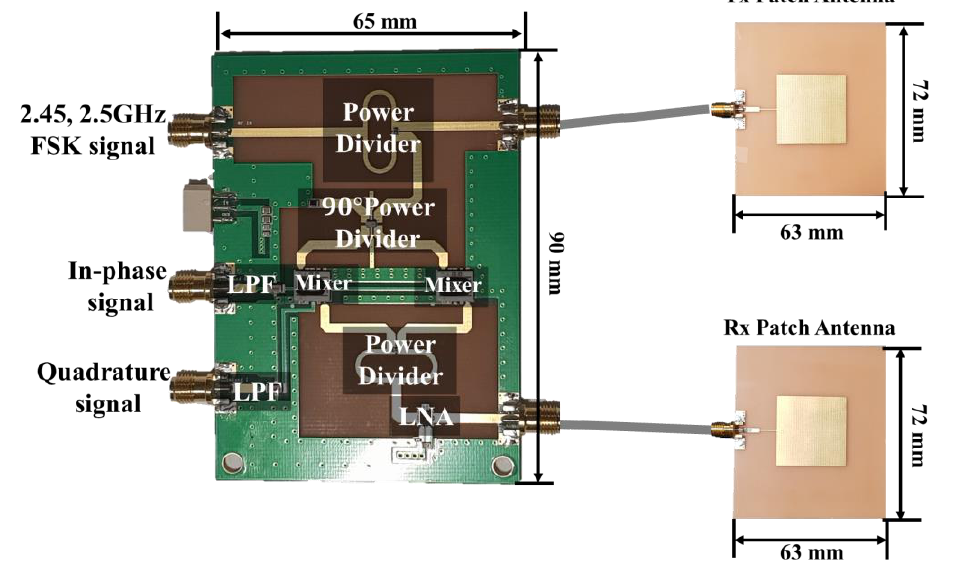
Figure 7. Implemented radar module with two patch antennas on an FR4 printed circuit board (PCB).